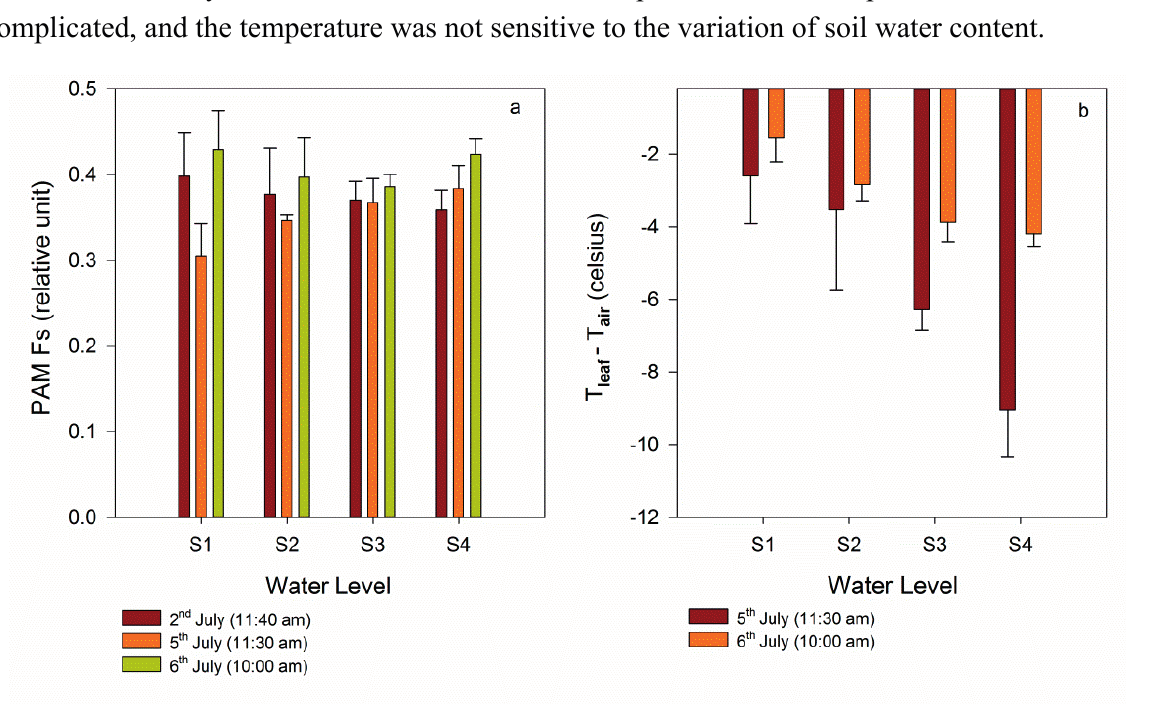
Figure 5. Comparison of the Fs ( a ) and T leaf -T air ( b ) of the four